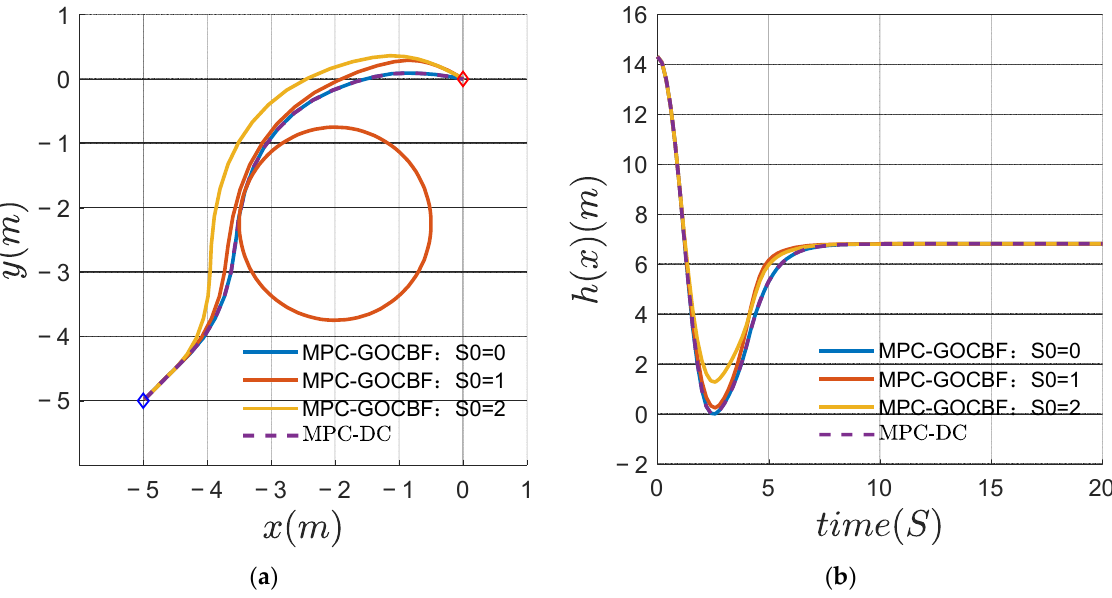
Figure 6. Compare the obstacle avoidance behaviors generated by MPC-DC and MPC-GOCBF: ( a ) the trajectory of MPC-GOCBF with different S 0 and MPC-DC; ( b ) the CBF h(x) values of MPC-GOCBF and